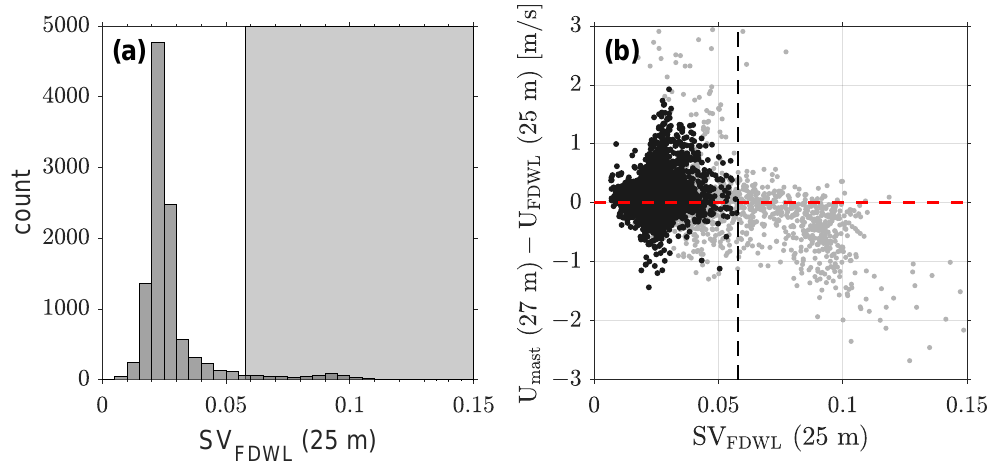
Figure 5. Lidar data screening: spatial variation. ( a ) SV histogram for the FDWL at a 25 m height (refer to Figure 1). Grey shading indicates the upper tail of the 5% area corresponding to the rejected outliers in the SV distribution (95th to-100th percentiles). ( b ) Same format as in Figure 4 but using SV as the dependent variable. The dashed vertical line indicates the 95th percentile of the SV threshold.